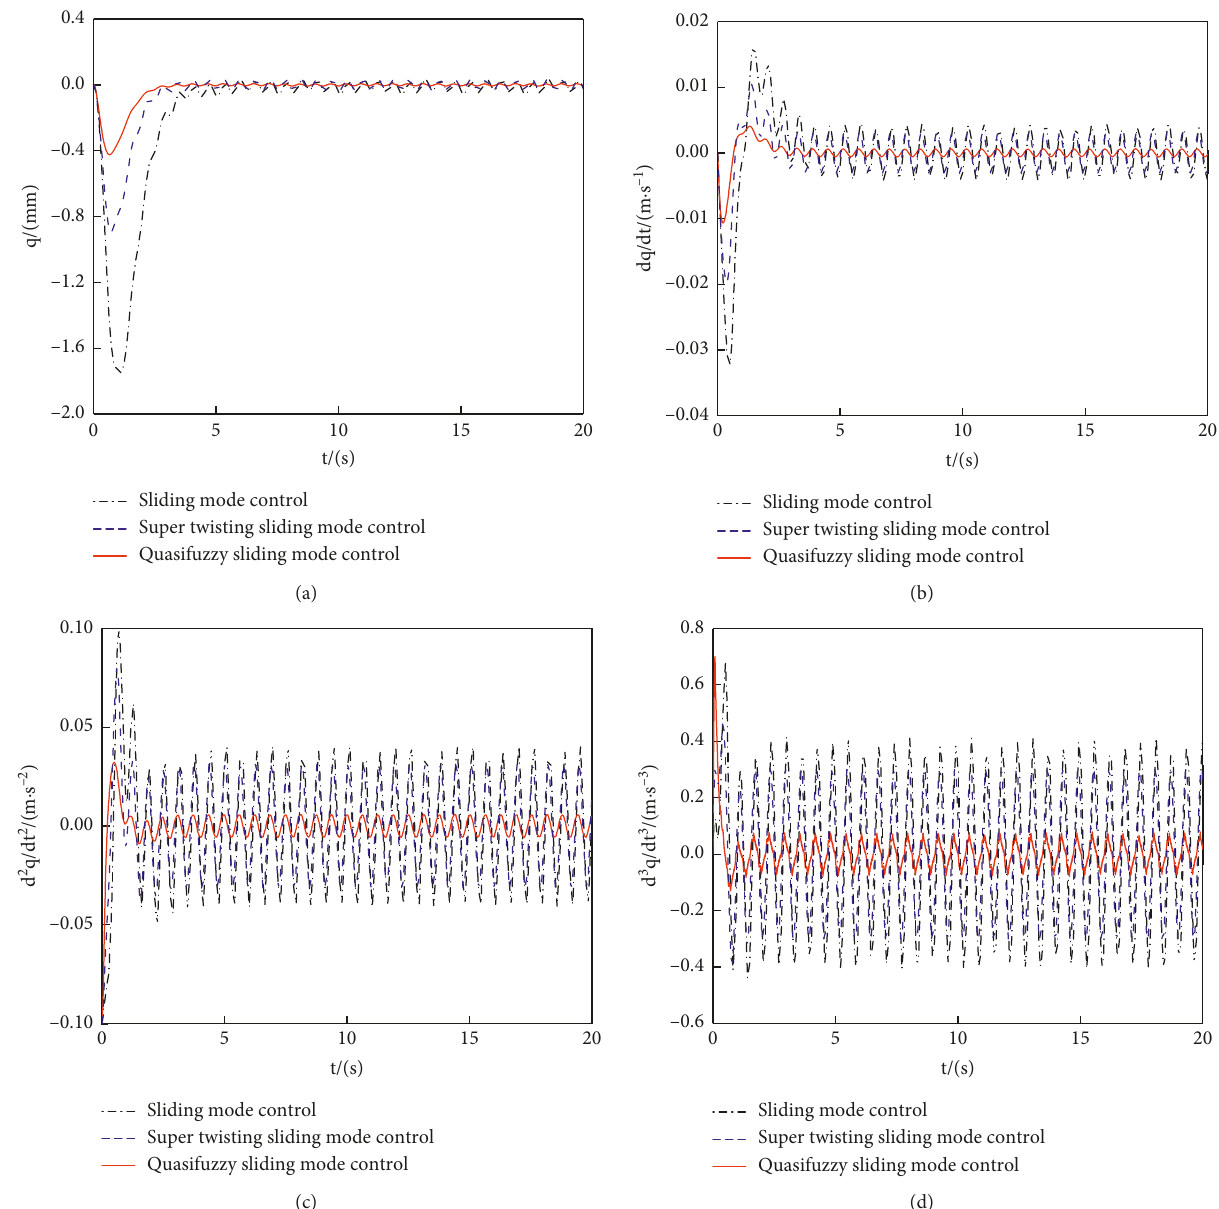
Figure 8: Response characteristic curves. (a) Response curve of q . (b) Response curve of _ q . (c) Response curve of € q . (d) Response curve of q ...